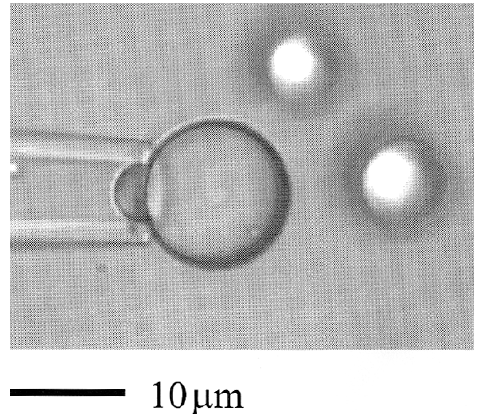
Figure 23. Single water microdroplet held by the micropipette in heptol solution (1:1 mixture, by volume, of n ‐ heptane and toluene). The water ‐ oil interfacial tension of 40.3 ± 0.6 mN/m was directly measured from the geometrical shape of the microdroplet and the minimum pressure required to draw in the droplet to give a projection length inside the pipette of one pipette radius. With permission from Elsevier [11].